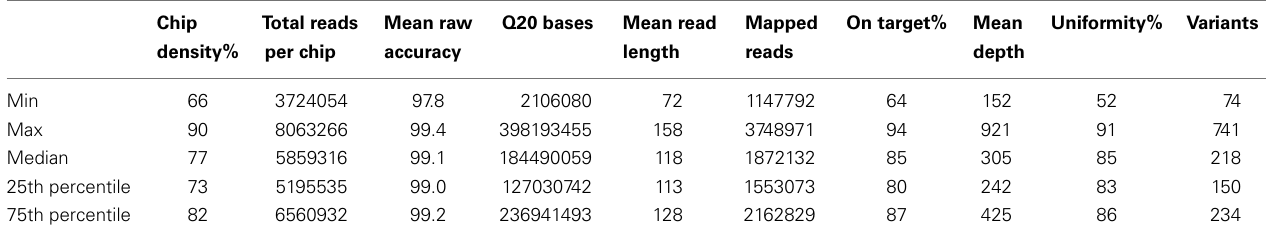
Table 1 | Run metrics (30 runs, 84 samples) .